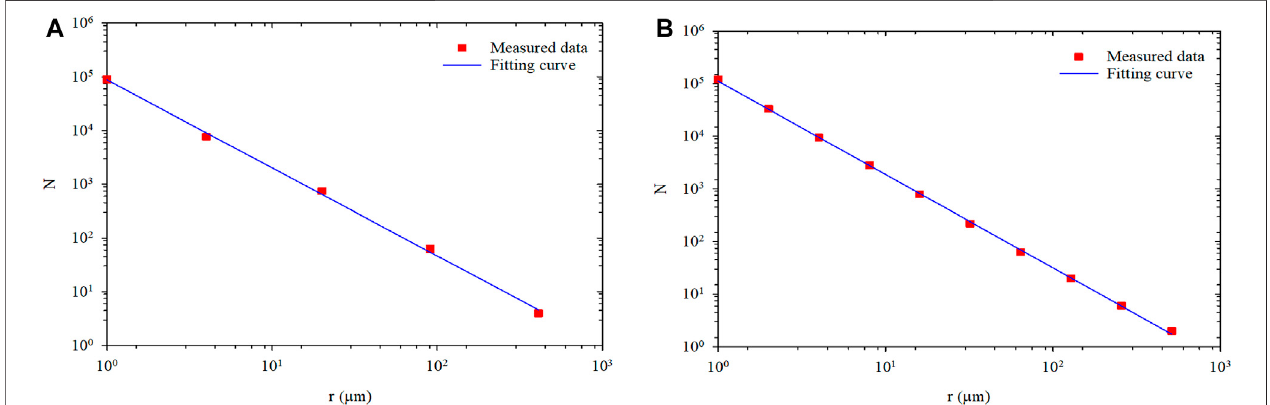
FIGURE 7 | The number of boxes in various box sizes at the different hydration times in log-log coordinate: (A) Hydration initial state; (B) Hydration 1 day.